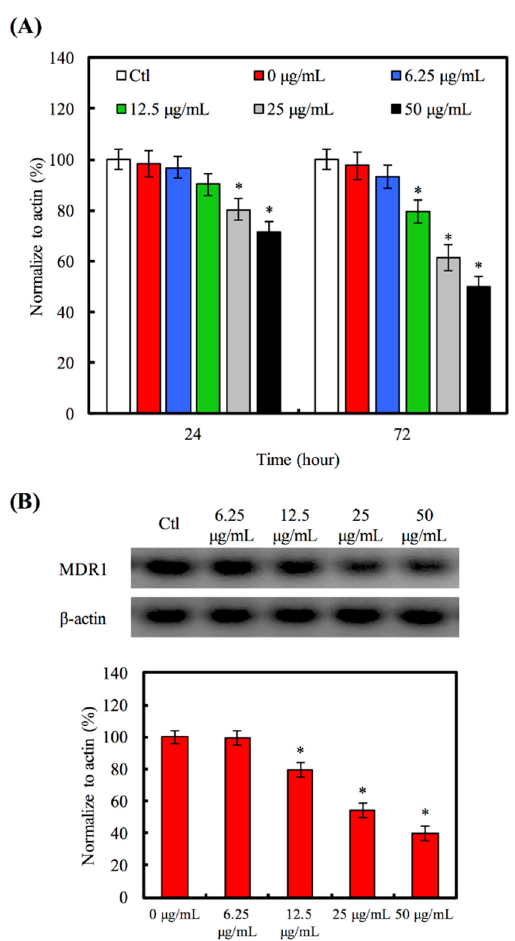
Figure 5. The MDR1 ( A ) gene and ( B ) protein expression of A549 cell cultured with various groups of Hino-MCS nanoparticles for three days. Star indicates a significant difference ( p < 0.05) compared to 0 μ g/mL.